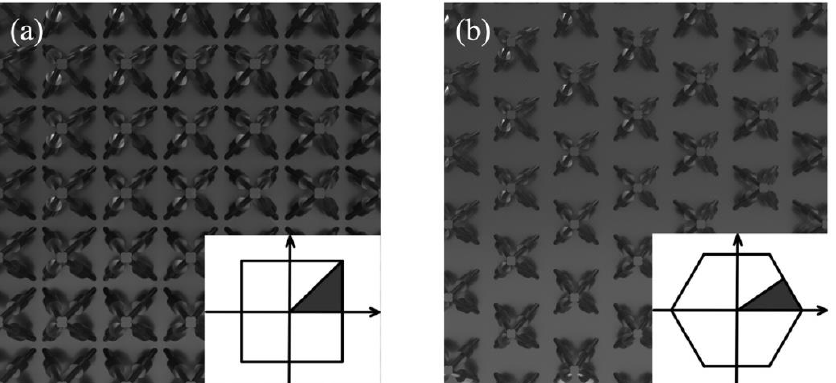
Figure 12. Distribution forms of SPLCRR plate for ( a ) square and ( b ) triangular lattices. First irreducible Brillouin zone in shaded region for ( a ) square and ( b ) triangular lattices.